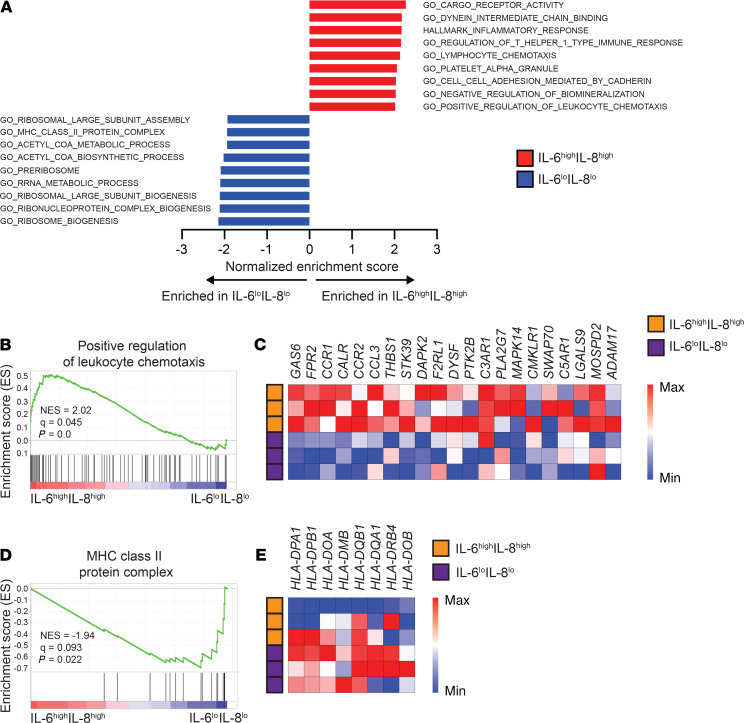
Circulating monocytes in patients with elevated inflammatory cytokines display distinct transcriptional programming.(A) Top gene sets enriched in monocytes from patients (n = 6) with high (IL-6hiIL-8hi) or low (IL-6loIL-8lo) plasma IL-6 (cutoff 10 pg/mL) and IL-8 (cutoff 45 pg/mL). (B) Enrichment plot of positive regulation of leukocyte chemotaxis from gene set enrichment analysis (GSEA) shown in A. (C) Heatmap of selected genes from the positive regulation of leukocyte chemotaxis gene set enriched in IL-6hiIL-8hi monocytes. (D) Enrichment plot of MHC class II protein complex from GSEA shown in A. (E) Heatmap of selected genes from the MHC class II protein complex gene set enriched in IL-6loIL-8lo monocytes. NES, normalized enrichment score; Gas6, growth arrest specific 6.